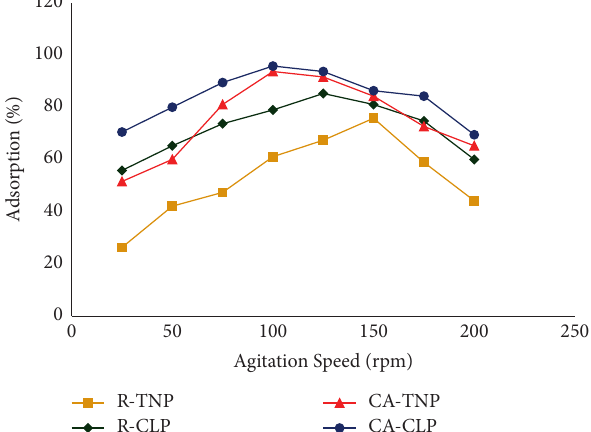
Figure 9: Effect of agitation on adsorption. Experimental conditions: agitation speed range 25 to 200rpm, conc. � 25ppm, volume � 25mL, adsorbent dose � 0.6g, contact time � 30 min, temperature 30 ° C, initial pH � 5, and final pH: R-TNP � 5, R-CLP � 4.5, CA-TNP � 4.0, and CA-CLP � 4.0.